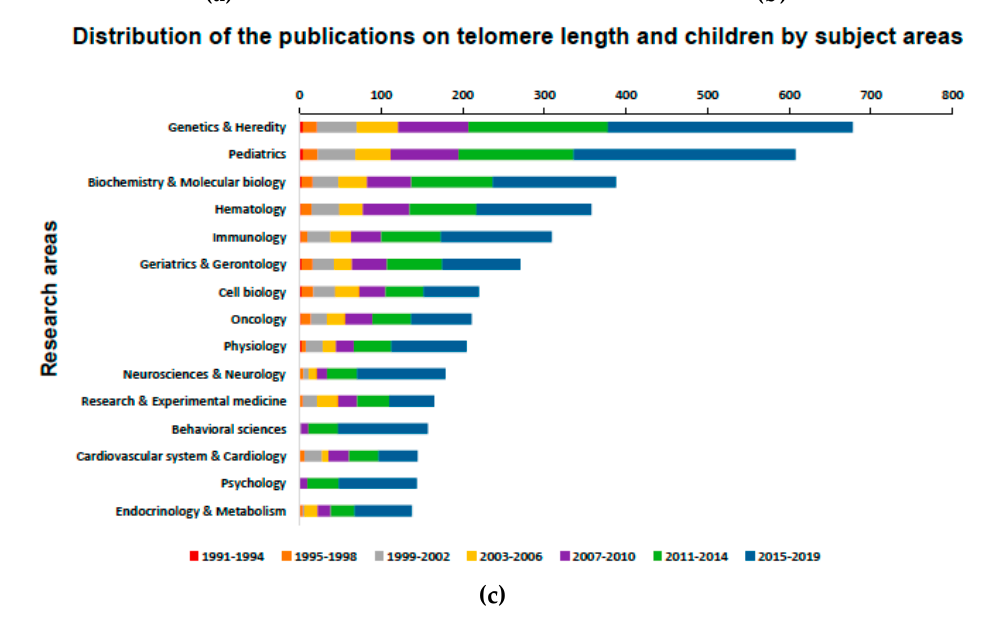
Figure 2. Distribution of the publications on telomere length in children by document type ( a ), general categories ( b ), and subject areas ( c ) over the period from 1991 to 2019.